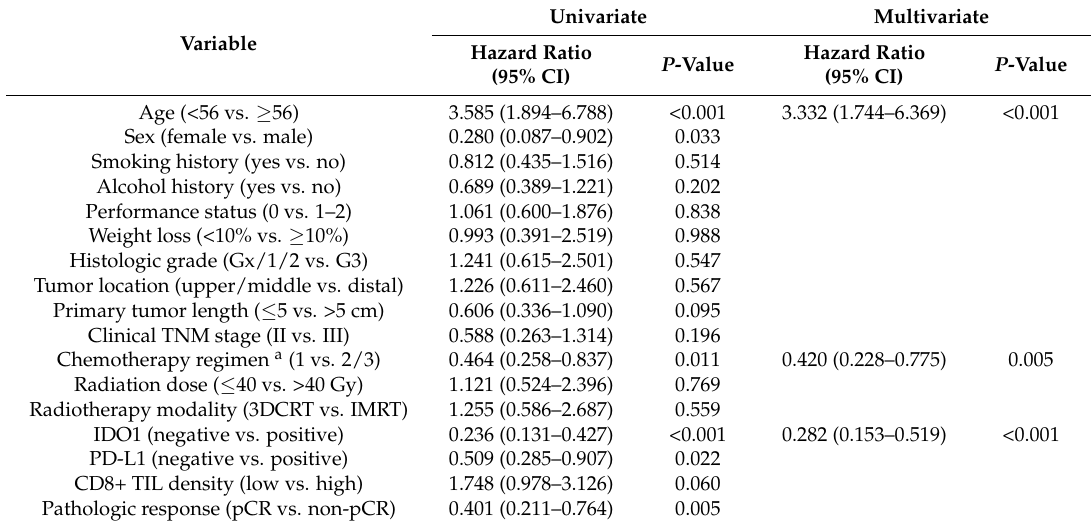
Figure 4. Comparison of overall survival ( A ) and recurrence-free survival ( B ) between patients with positive or negative IDO1 expression. Comparison of overall survival ( C ) and recurrence-free survival ( D ) between patients with positive or negative PD-L1 expression. Comparison of overall survival ( E ) and recurrence-free survival ( F ) between patients with high or low CD8 density. Table 4. Univariate and multivariate analyses for recurrence-free survival.